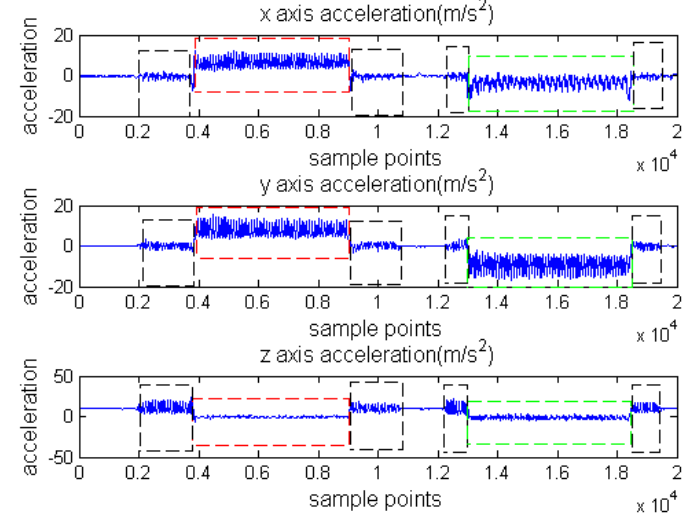
Figure 6. Acceleration of different